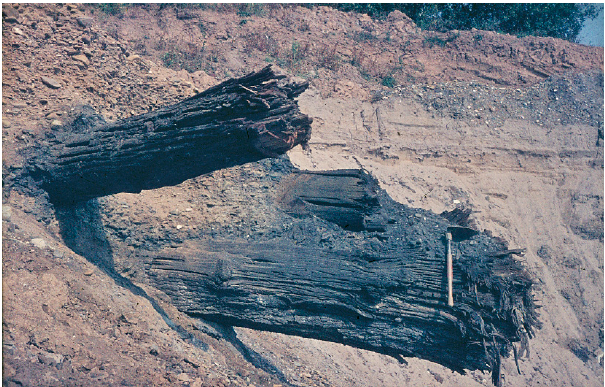
Figure 20. Rannen (fossil tree trunks) in the Zettlitz Flument (226 BC–130 AD) in a gravel pit at Lichtenfels ‐ Trieb/Bavaria. Stratigraphical position see Figure 18 (Photo: W. Schirmer 19 September 1971).